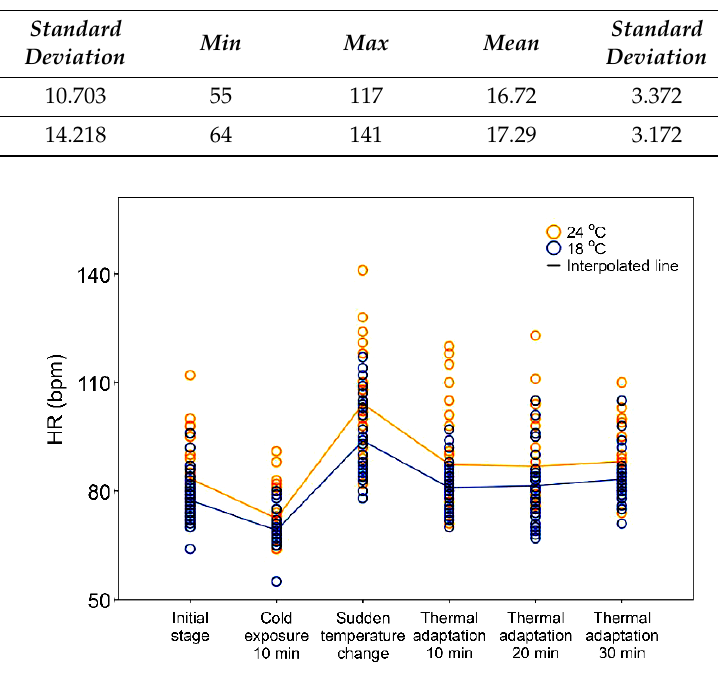
Figure 9. Distribution law of HR across different temporal phases.